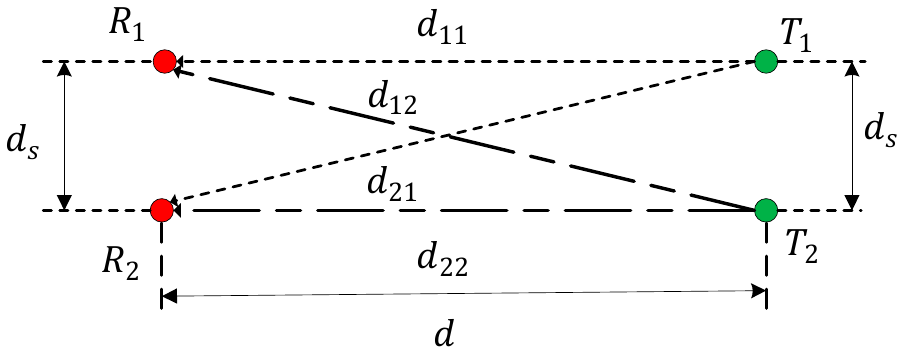
Figure 4. Rectangular 2 × 2 transceiver antenna array.